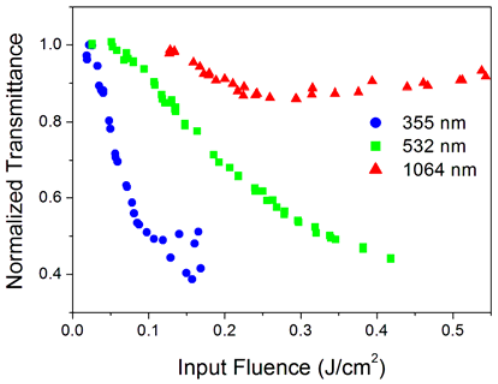
Figure 3. Normalized transmittance of the NH4 sample at 0.025 g/L as a function of the input energy spatial density (input fluence).